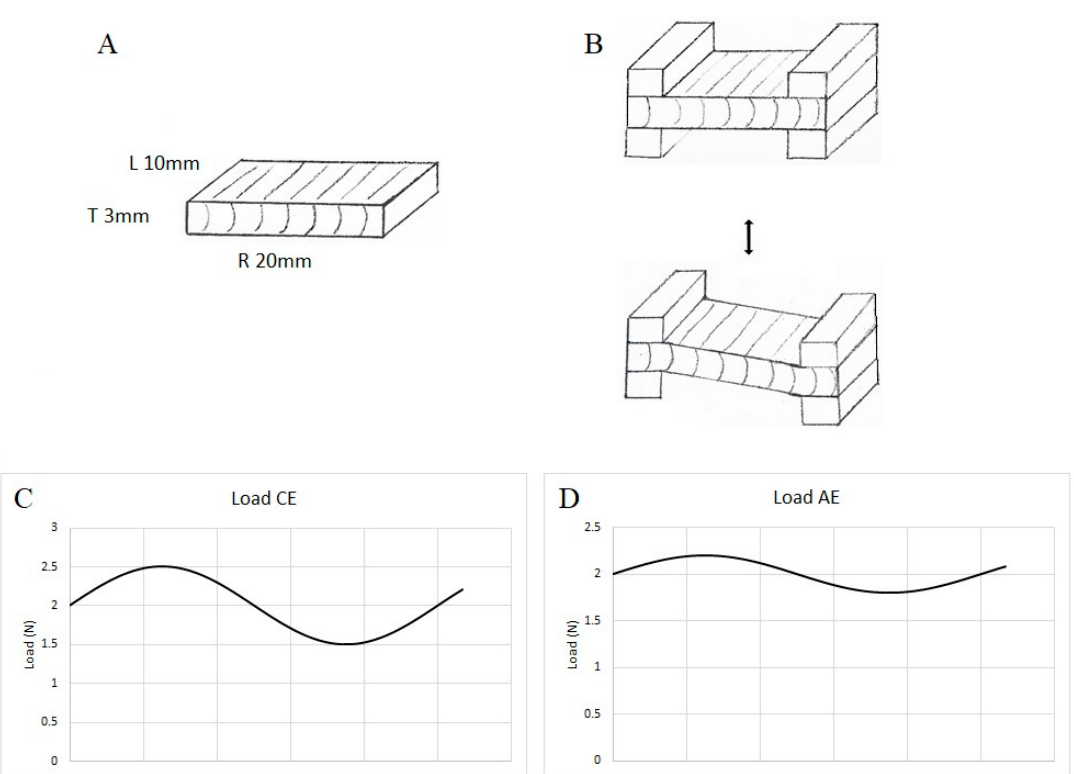
Figure 2. DMA sample indicating the orientation of the longitudinal (L), radial (R) and tangential (T) directions ( A ); schematic indicating the radial bending motion achieved by oscillation of one clamp in the tangential direction during the single cantilever mode test ( B ); oscillating load for CE samples with dynamic load 0.5 N and static load 2 N ( C ); applied load for AE samples with dynamic load 0.2 N and static load 2 N ( D ).